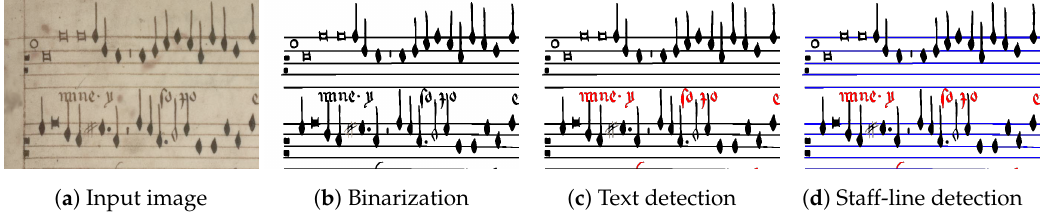
Figure 2. Typical sub-tasks related to documents processing for musical